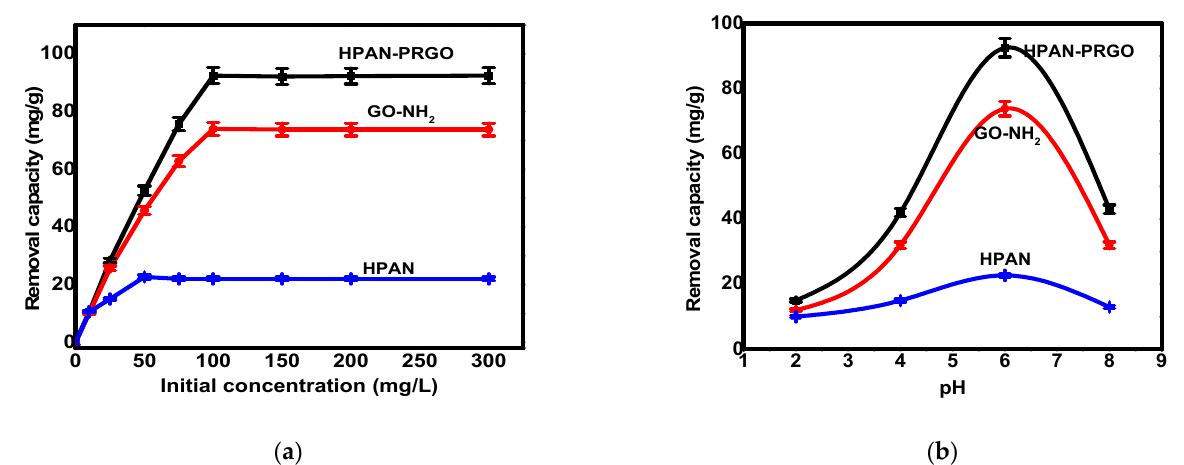
Figure 5. The effect of ( a ) the initial concentration and ( b ) solution pH on Sm 3+ removal over HPAN-PRGO, GO-NH 2 , and HPAN.